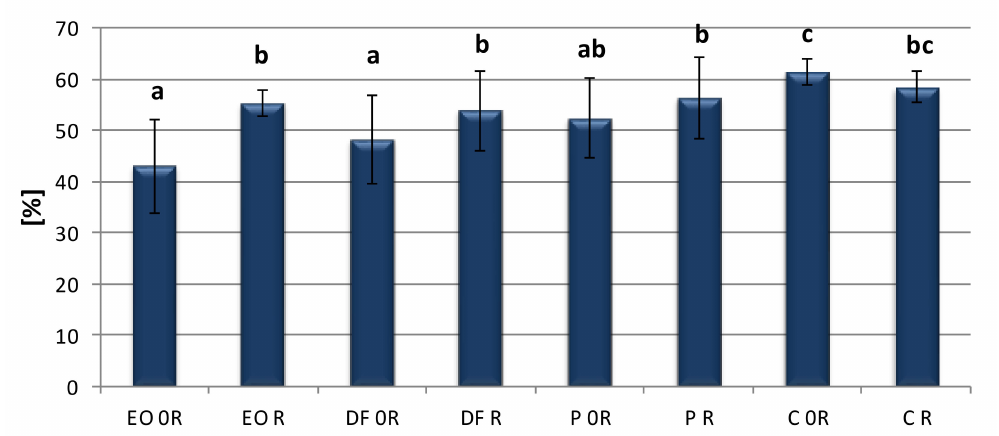
Figure 2. The e ff ect of petroleum-derived substances and bioremediation on the percentage of leaves damaged by Sitona spp. (%). Symbols as in Table 1. Means ( ± SE) marked with the same letters do not di ff er significantly according to the LSD test at p < 0.05.